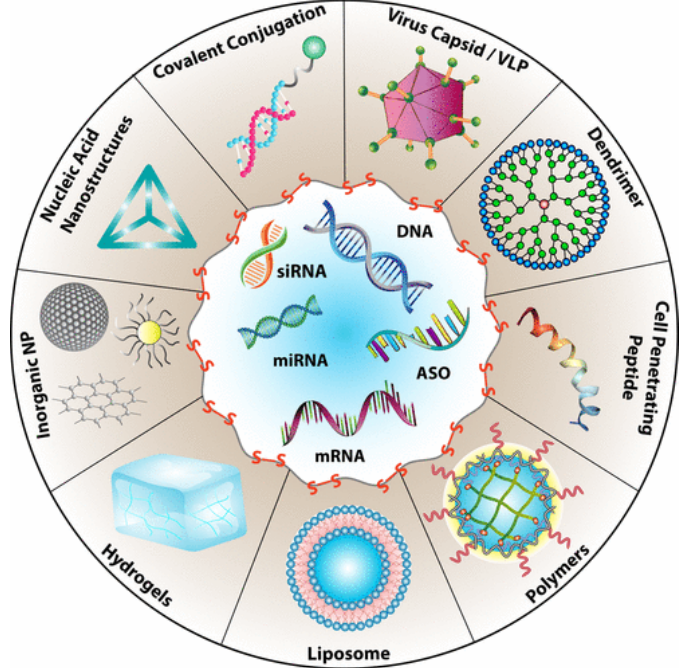
Figure 3. Types of drug delivery systems that rely on the presence of disulfide bonds for the targeted delivery of nucleic acids. Reprinted with permission from [10]. Copyright (2021) American Chemical Society.